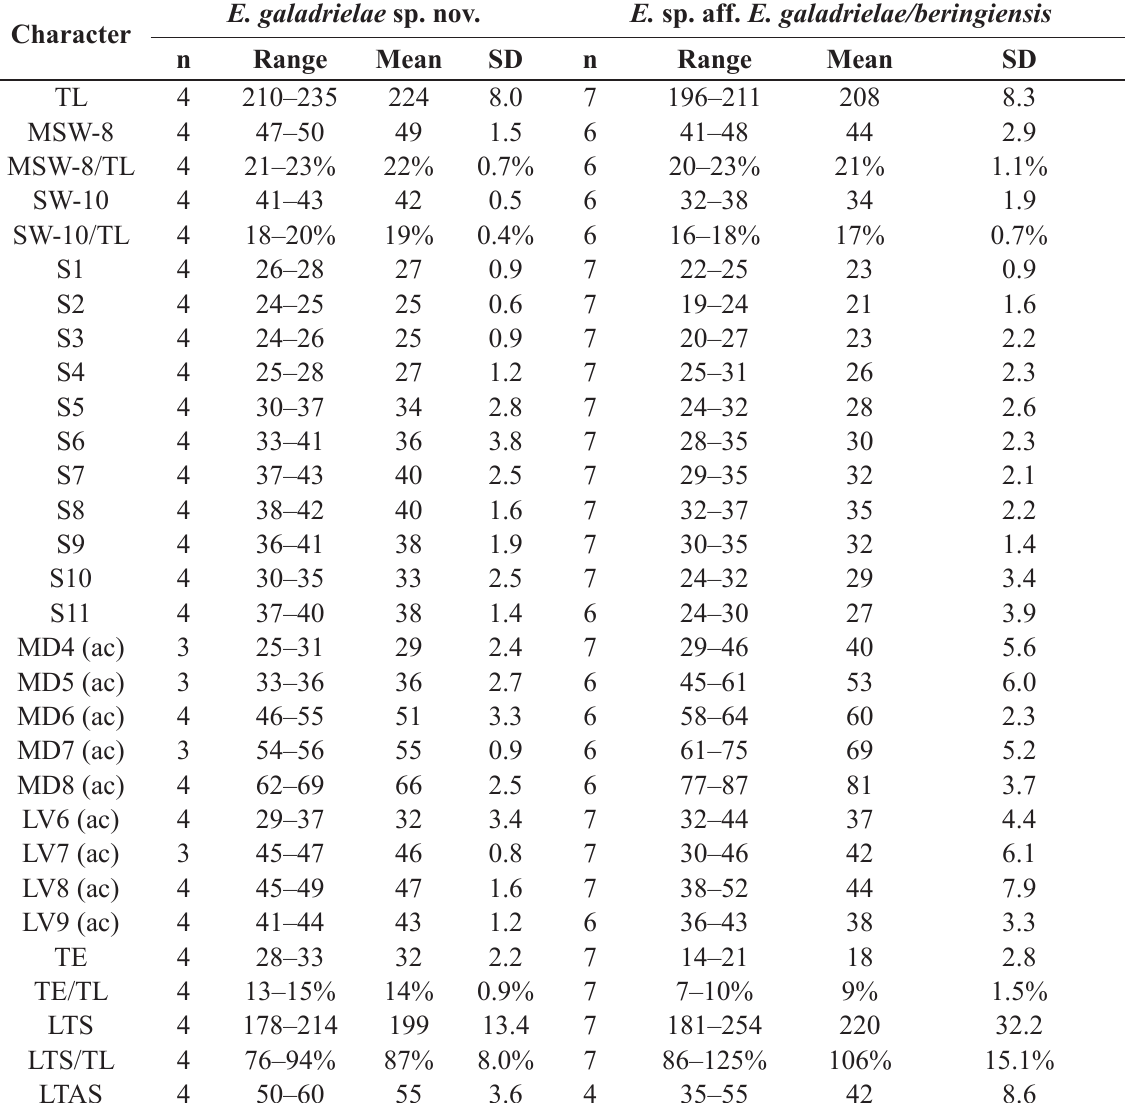
Table 20. Measurements from light microscopy of Echinoderes galadrielae sp. nov. (in µm) from the Hikurangi Margin, including number of measured specimens (n) and standard deviation (SD). Left part of the table shows ranges for E. galadrielae sp. nov., right part shows ranges for Echinoderes sp. aff. E. galadrielae / E. beringiensis with shorter tergal